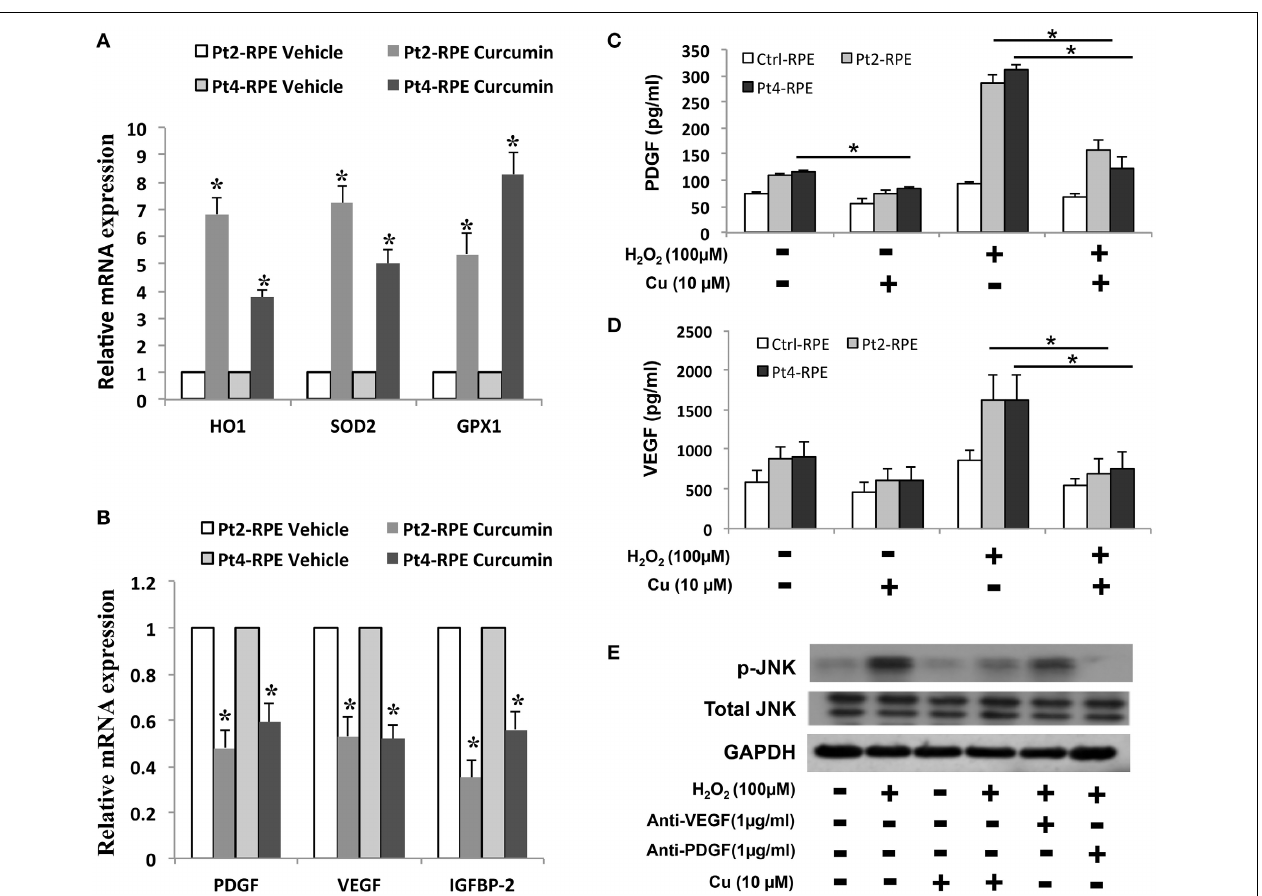
FIGURE 6 | Modulation of curcumin in oxidative stress-regulating genes. qRT-PCR was used to quantify the relative amounts of (A) antioxidant genes and (B) growth factors in the indicated groups. Each bar represents the mean ± SD of three independent experiments ( ∗ p < 0 . 01 compare with vehicle control). Levels of platelet-derived growth factor (PDGF) and (C) vascular endothelial growth factor (VEGF) (D) of AMD-RPEs in the